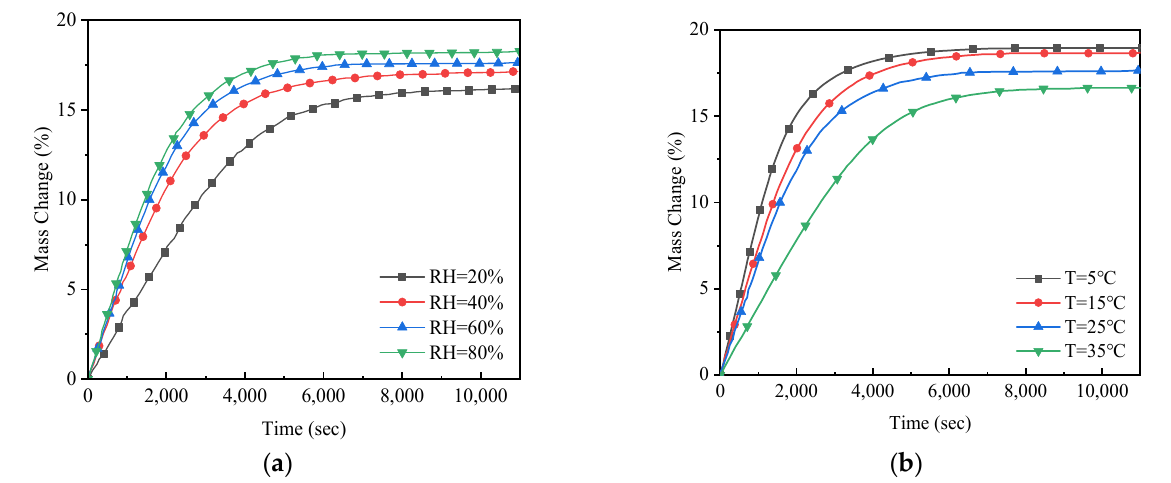
Figure 7. Adsorption curve of MOF-801/CNT at different humidity and temperature. ( a ) Adsorption curve of MOF-801/CNT at T = 25 °C and different humidity. ( b ) Adsorption curve of MOF-801/CNT at RH = 60% and different